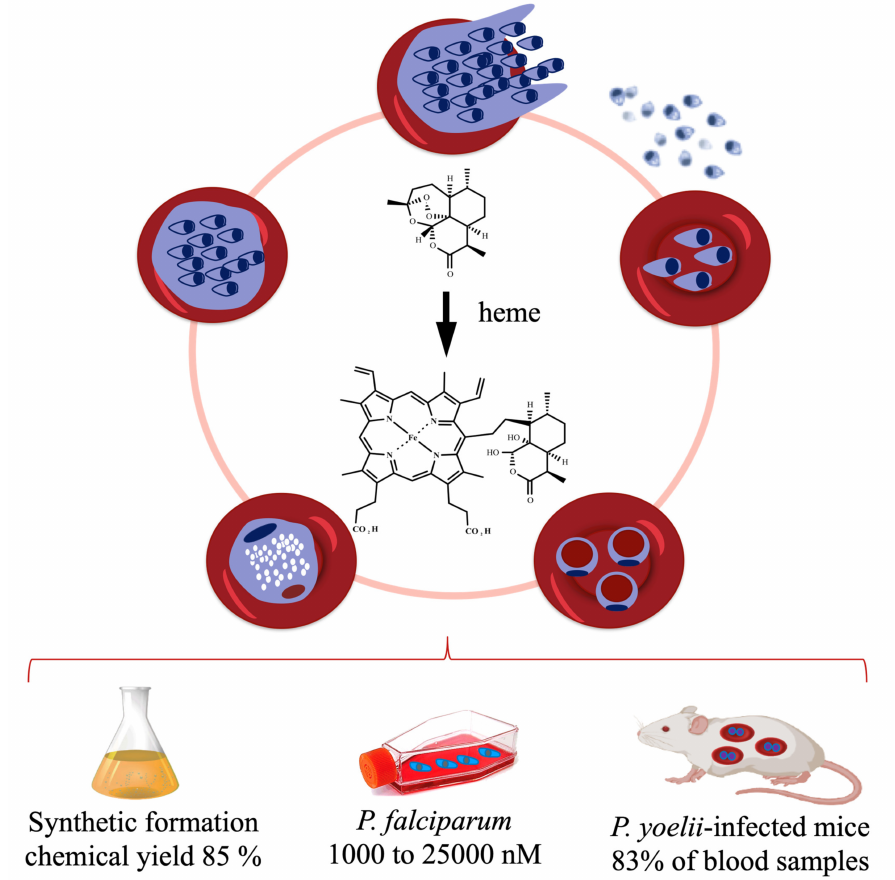
Figure 3. Activation of antimalarial endoperoxides by heme to hematin–drug adducts. This can be synthetically reproduced in the laboratory under mild conditions, producing high chemical yields [57]. Biogenically formed hematin–drug adducts were detected in high concentrations in a cell culture of P. falciparum treated with 5000 nM of dihydroartemisinin [62] and were detected at 83% in blood samples from infected mice treated with artemisinin [63]. For P. falciparum , a hematin-dihydroartemisinin adduct is produced, but for clarity its structure is not depicted